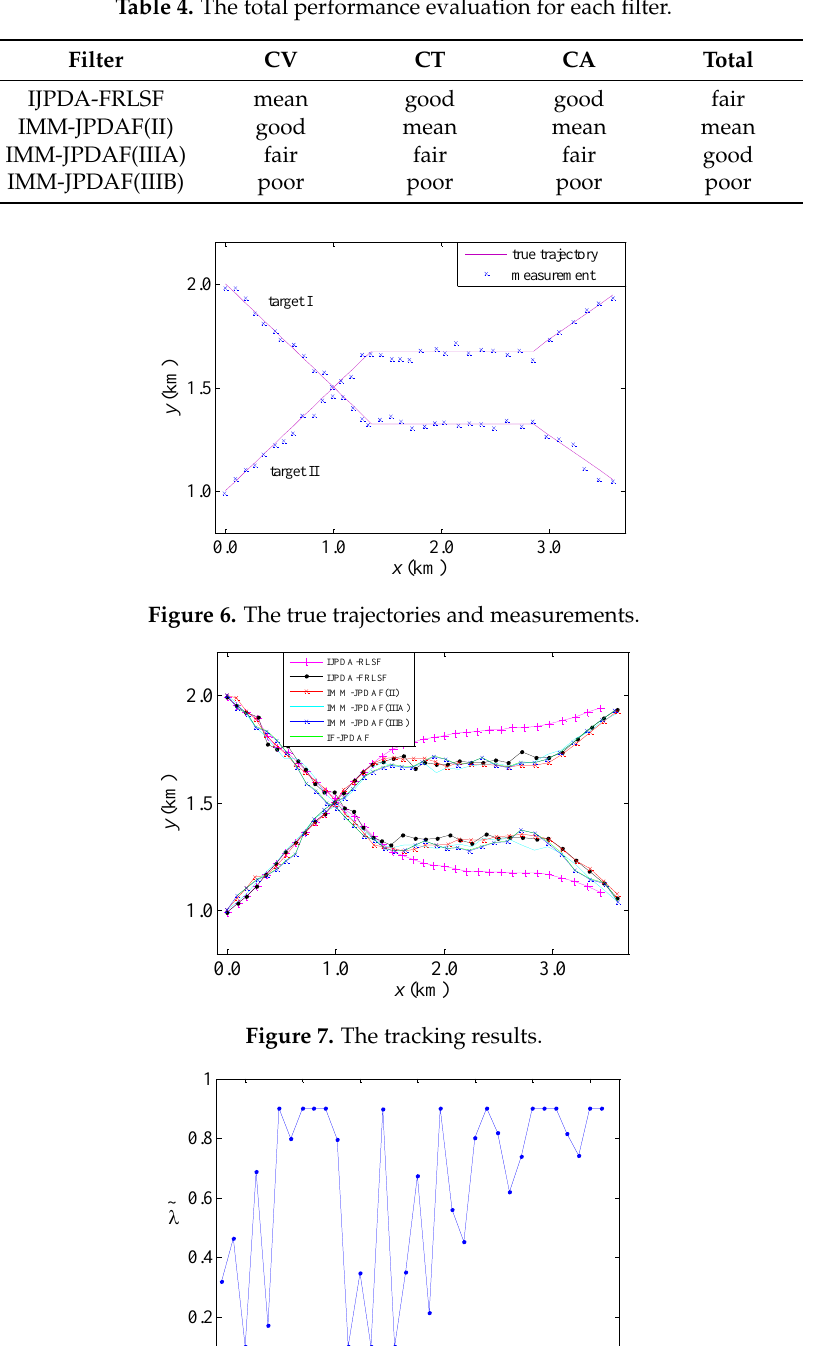
Figure 9 . The estimates of  for target II. Figure 10. The estimated error for the target I.